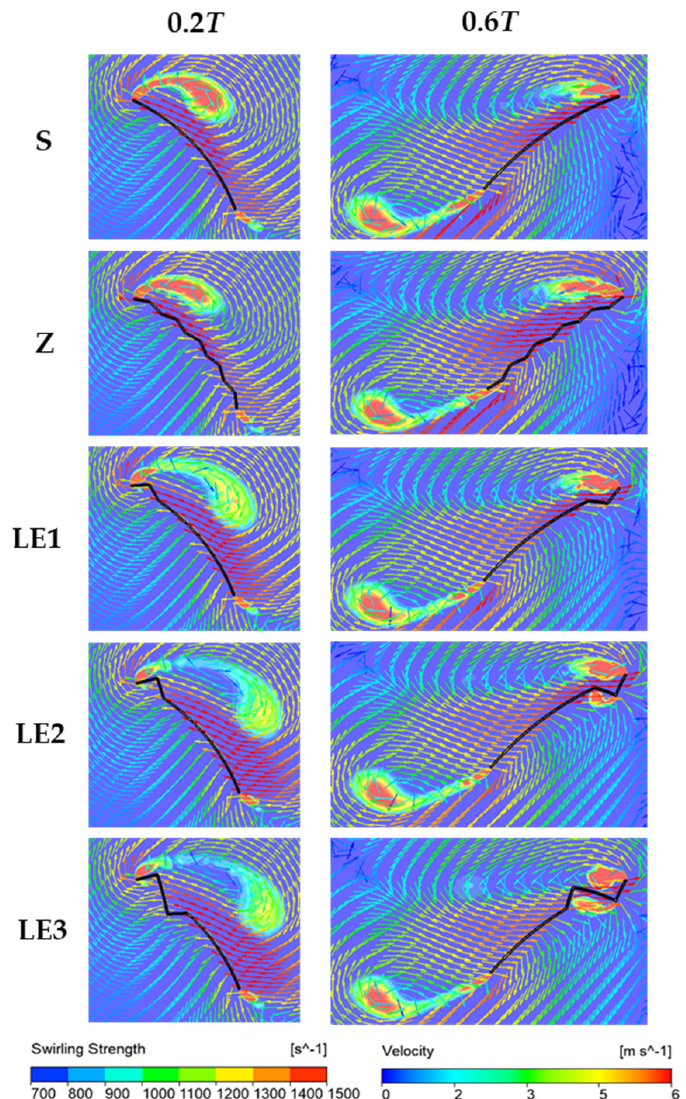
Figure 12: Flow fields and swirling strength around the five wings at r =0.75 R . Figure 12. Flow fields and swirling strength around the five wings at r = 0.75 R